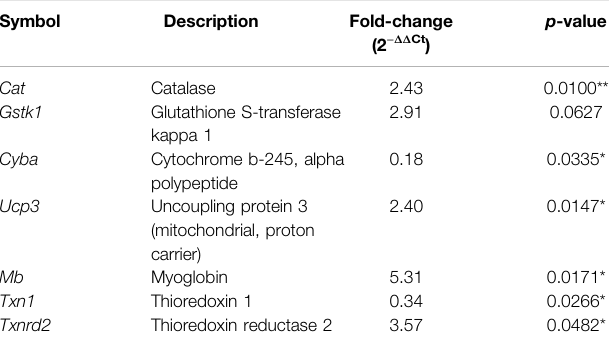
TABLE3| Expressionofoxidativestress-associatedgenesafterSMFtreatmentin UFPM-exposed rats with MI. Symbol